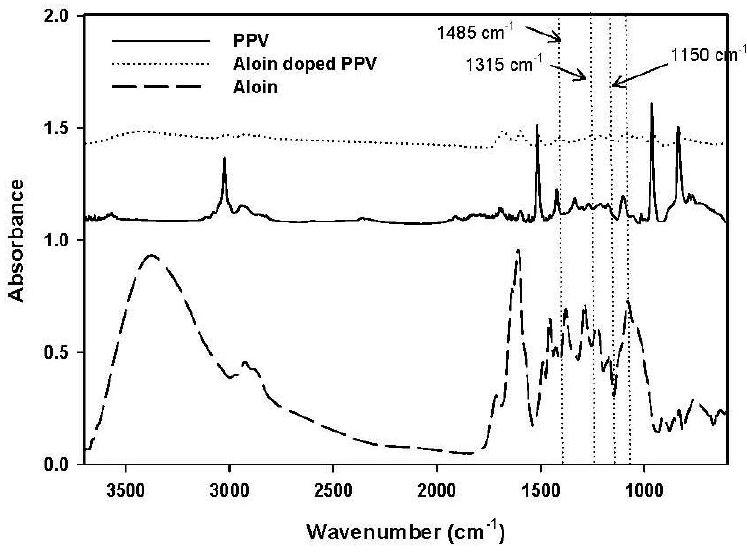
Figure 4. Absorption infrared spectra of poly(phenylene vinylene), PPV; aloin; and aloin doped poly(phenylene vinylene), aloin doped PPV.